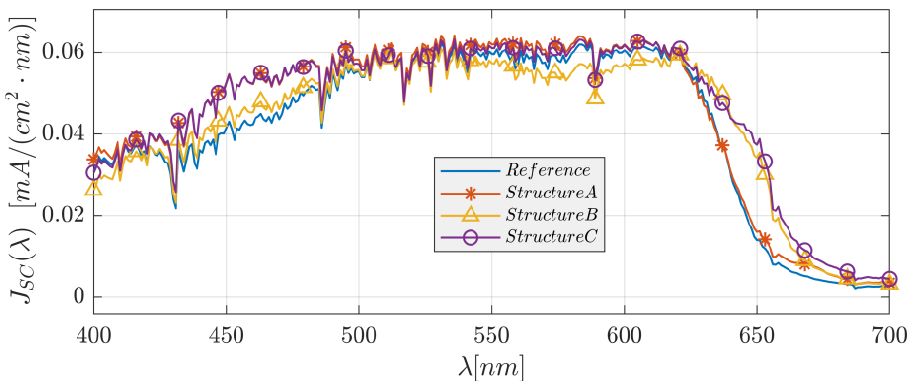
Figure 5. The spectral absorptance in the active layer (full lines) and the reflection efficiency (dashed lines) for the various cells.